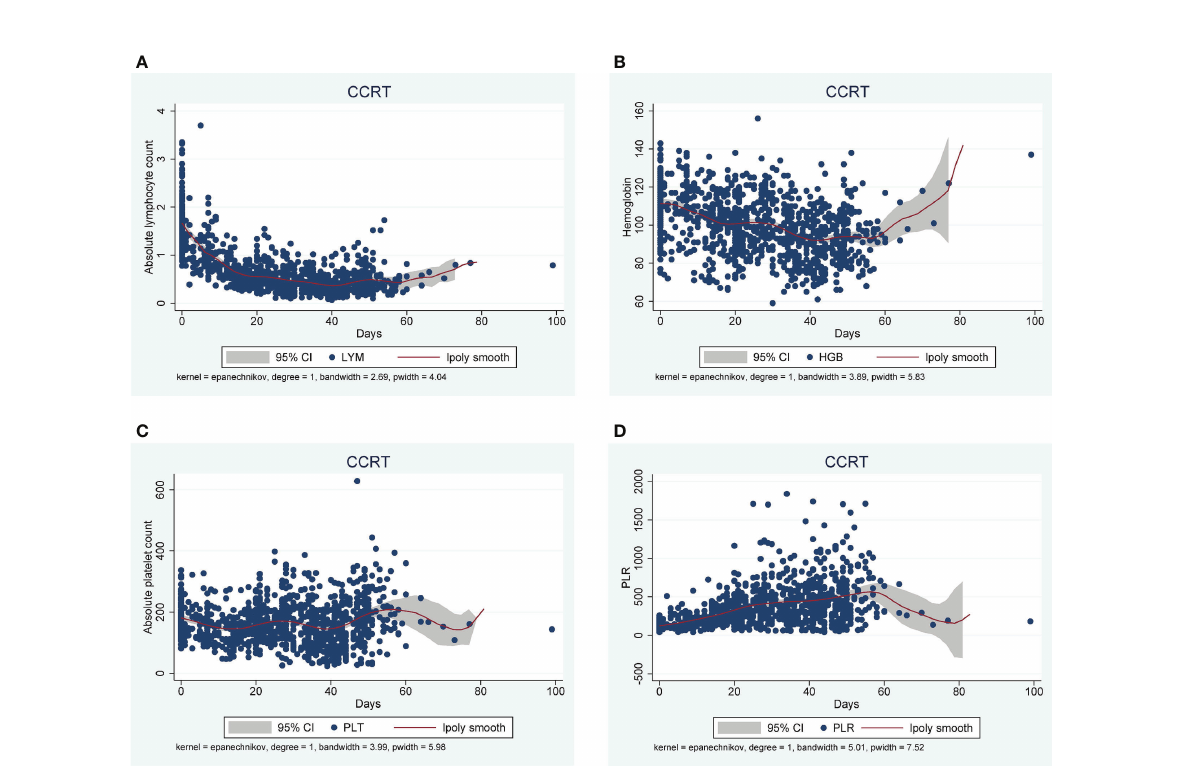
FIGURE 1 Changes in hematological parameters during CCRT, including absolute lymphocyte count (LYM)(10 9 /L) (A) , hemoglobin(HGB) (g/L) (B) , absolute platelet count (PLT)(10 9 /L) (C) , and platelet-to-lymphocyte ratio (PLR) (D) .